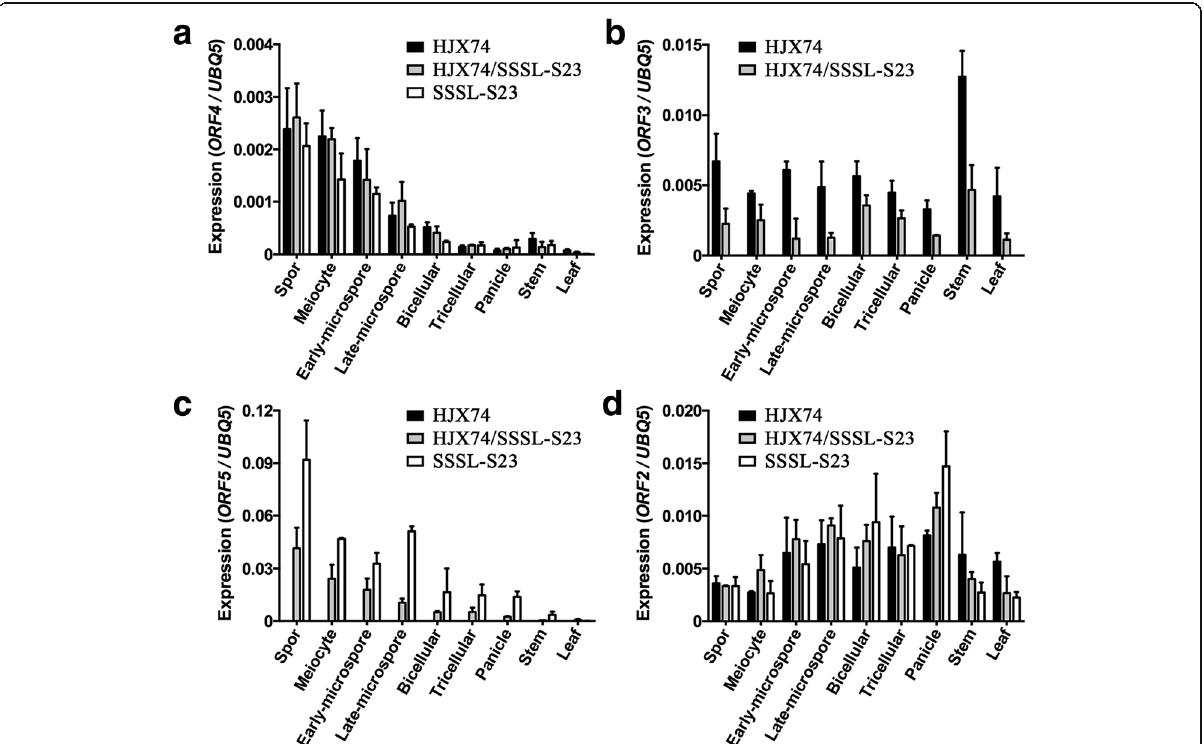
Fig. 5 Expression analysis of S23 candidate genes. The expression of ORF4 ( a ), ORF3 ( b ), ORF5 ( c ) and ORF2 ( d ) was analyzed in developing anthers from sporogenous cell stage to tricellular pollen stage and in other tissues including panicles, stems and leaves of HJX74, SSSL-S23 and HJX74/SSSL-S23 F 1 plants in NSD. Spor, sporogenous cell